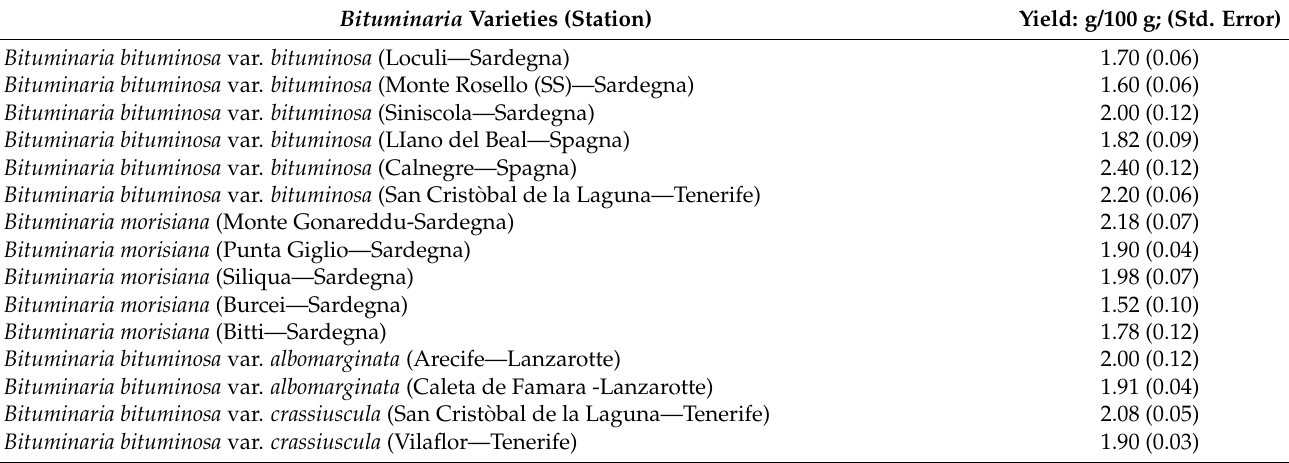
Table 5. Yield of methanolic crude extracts of Bituminaria varieties. Bituminaria Varieties (Station) Yield: g/100 g; (Std.